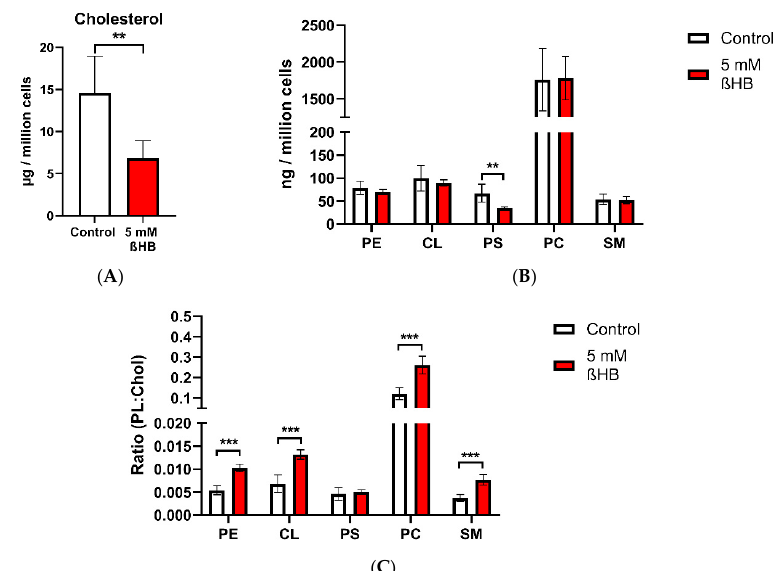
Figure 2. Cellular lipid quantities in HT22 neurons (control and ßHB-treated). Graph ( A ) represents cholesterol quantity (in µg per one million cells) measured using HPLC; graph ( B ) represents cellular phospholipid quantities (in ng per one million cells), measured using HPTLC; graph ( C ) represents the ratios of individual phospholipids to cholesterol in the control and beta-hydroxybutyrate-treated groups. Data are presented as mean + SD ( n = 4–6); ** p < 0.01, *** p < 0.001. Chol—cholesterol; CL— cardiolipin; PC—phosphatidylcholine; PE—phosphatidylethanolamine; PL—phospholipid; PS— phosphatidylserine; SM—sphingomyelin.